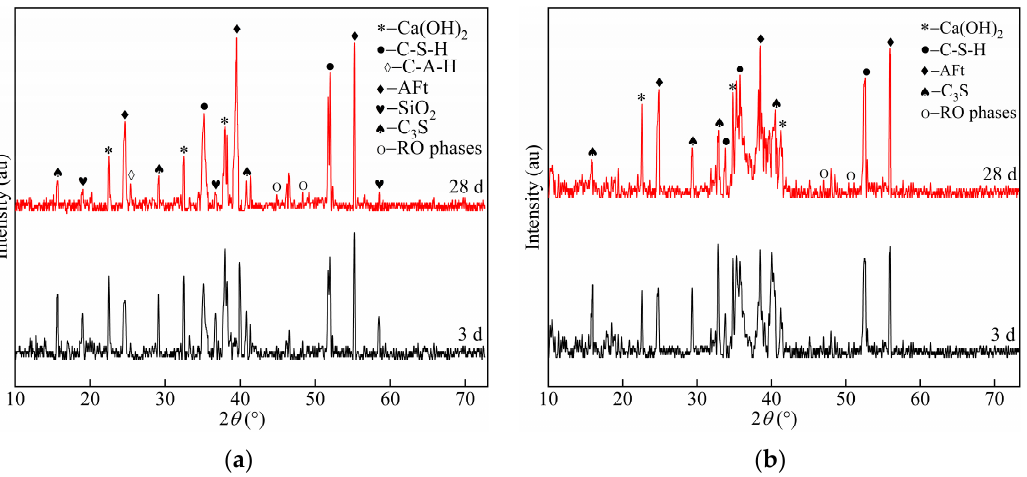
Figure 5. XRD patterns at 3 and 28 d of age according to the ( a ) optimized group samples and ( b ) reference group samples.